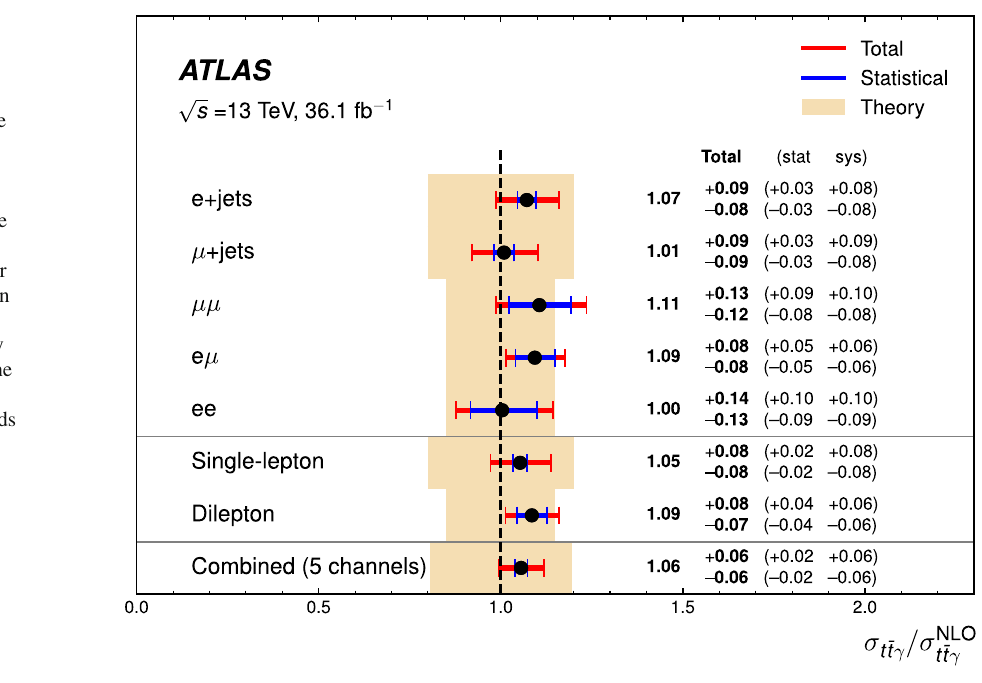
E miss T Table 5 Summary of the effects of the groups of systematic uncer-